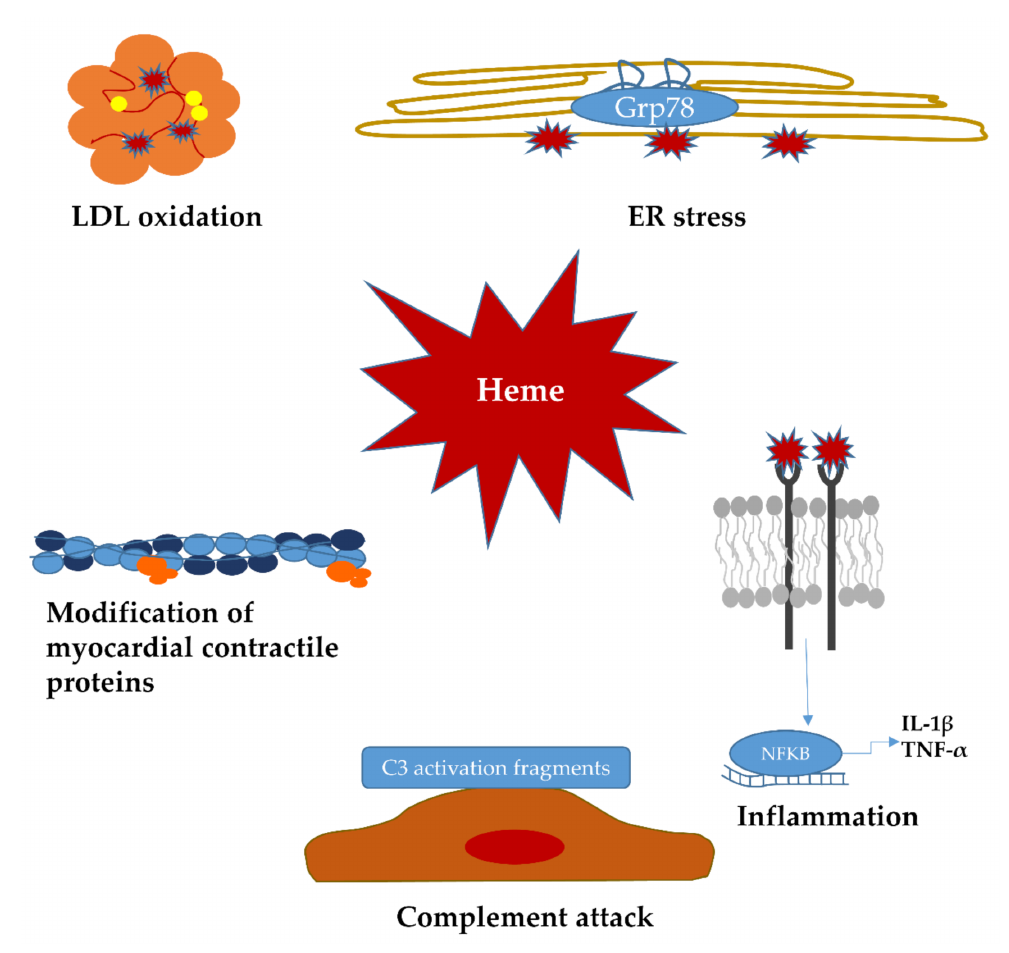
Figure 2. Mechanisms of heme-induced toxicity. Oxidation of hemoglobin results in heme release that triggers a wide range of cell damages. Heme intercalates into low-density lipoprotein (LDL) particles and amplifies LDL oxidation. Free heme induces the oxidative modification of myocardial contractile proteins and triggers endoplasmic reticulum stress in a variety of cells. Heme also mediates complement attack against the endothelium and possesses a potential pro-inflammatory effect. LDL: low-density lipoprotein; NFKB: nuclear factor kappa-light-chain-enhancer of activated B cells; IL-1 β : interleukin-1 β ; TNF- α : tumor necrosis factor- α ; Grp78: glucose-regulated protein 78; ER: endoplasmic